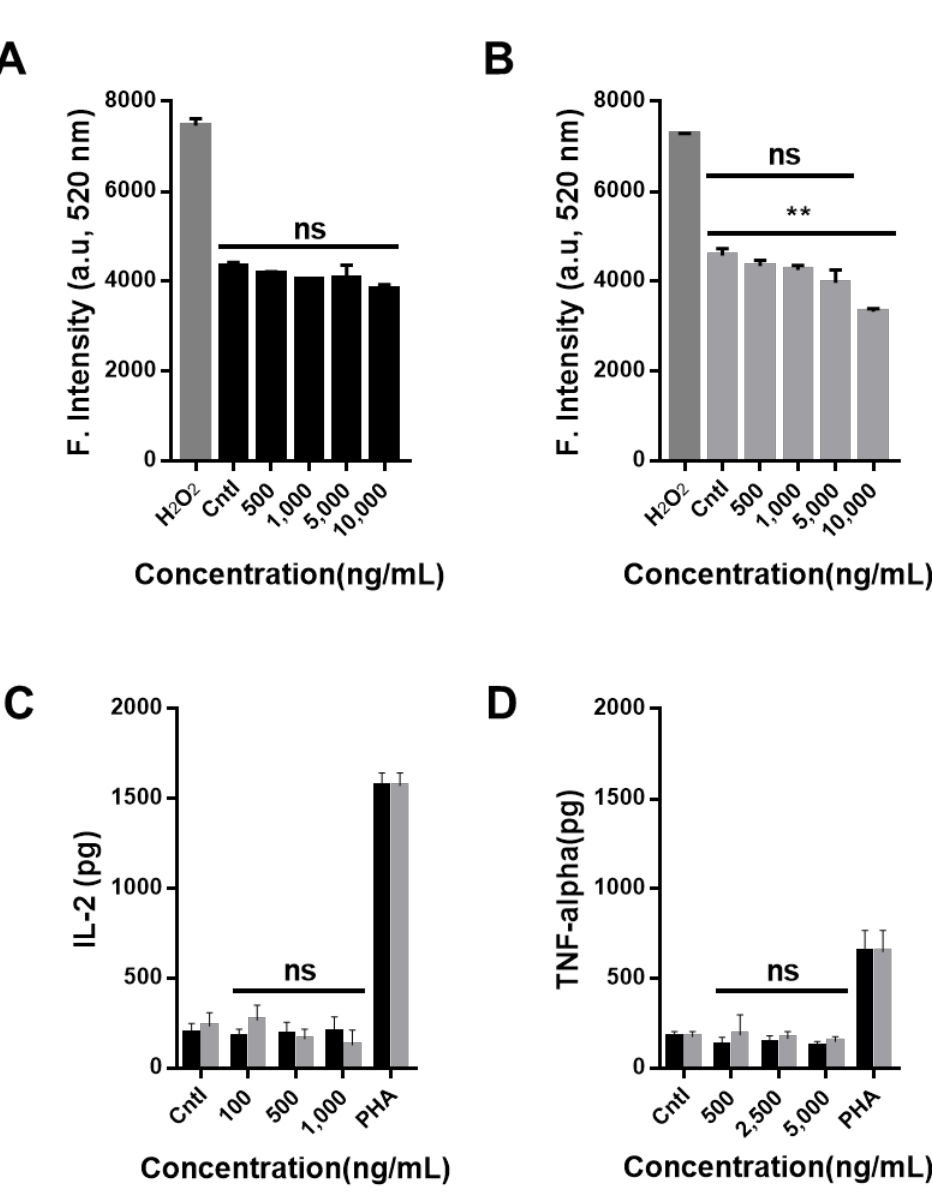
Figure 3. Fluorescence intensity according to the quantity of reactive oxygen species (ROS) of DCFDA (2’,7’ –dichlorofluorescin diacetate) on HDF cells after sample treatment with varying concentrations (500, 1000, 5000, and 10,000 ng/mL) for ( A ) CNO (black bar), and ( B ) CNO–COOH (gray bar); ( C ) production of IL-2 after sample treatment on PBMCs with varying concentrations (100, 500, and 1000 ng/mL); ( D ) production of tumor necrosis factor-alpha (TNF-alpha) after sample treatment on PBMCs with varying concentrations (500, 2500, and 5000 ng/mL).